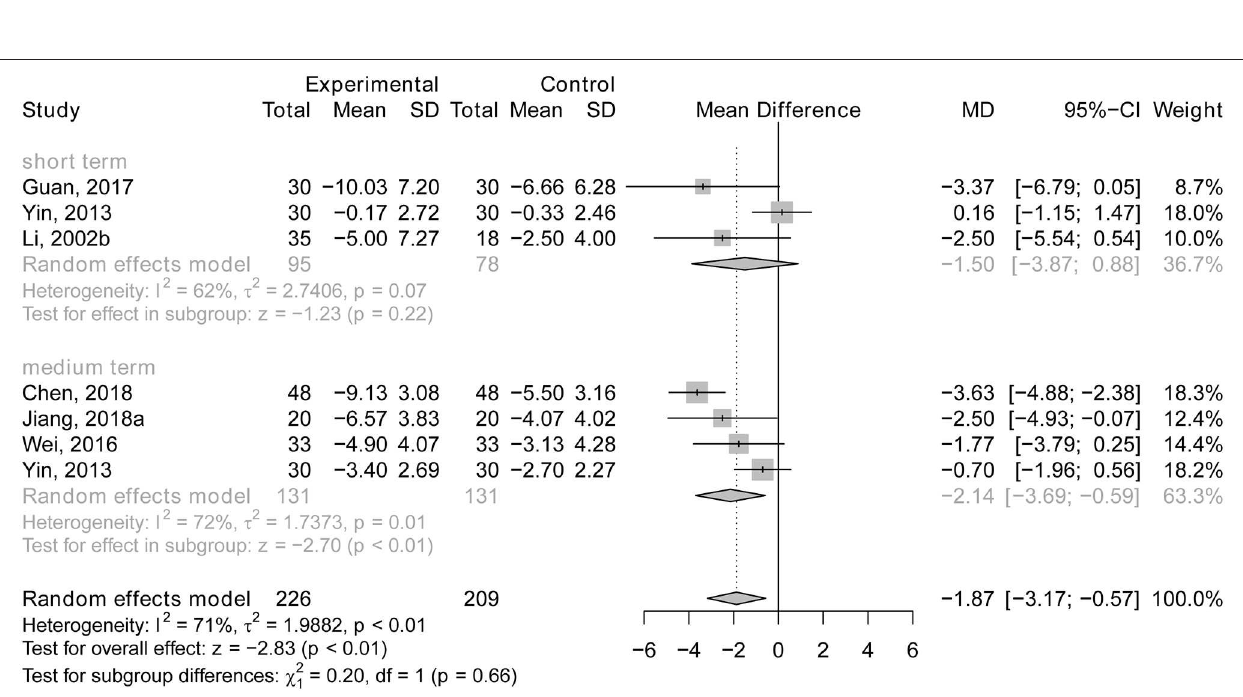
Frontiers in Aging Neuroscience |